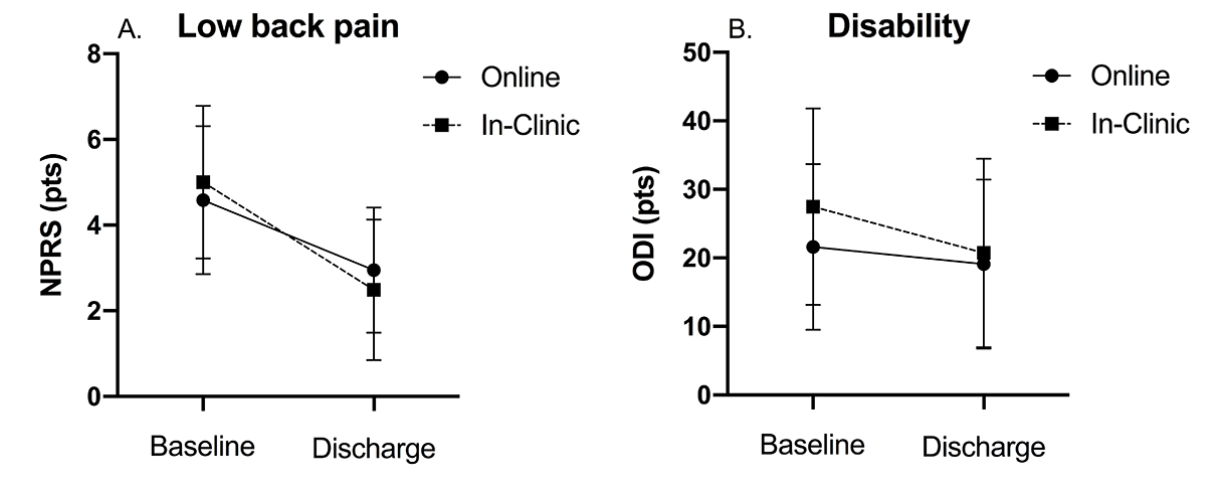
Figure 2. Mean and SDs for low back pain (A) and disability (B) between O-IPU (online) and C-IPU (in-clinic) groups at treatment baseline and